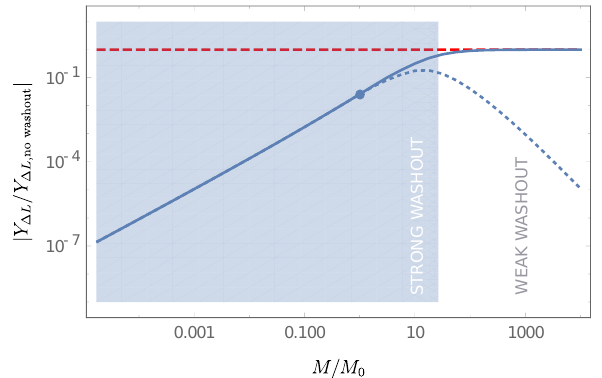
Figure 3 . Lepton asymmetry under a universal rescaling of the RHN masses ( M I ) in the early universe relative to today. The zero-temperature masses are M 0 and we use a Yukawa matrix compatible with oscillation measurements, see eq. (E.3). The horizontal dashed line corresponds to the maximum possible asymmetry (achieved with zero washout and initial equilibrium abundances for the N I ). The blue lines include washout e(cid:11)ects: the solid line corresponds to initial equilibrium abundances for the N I , and the dotted blue line corresponds to zero initial abundances. The blue dot corresponds to no di(cid:11)erence between the M I in the early universe and the present. The shaded blue region delimits the strong washout regime, K (cid:11) some (cid:13)avours I , (cid:11)